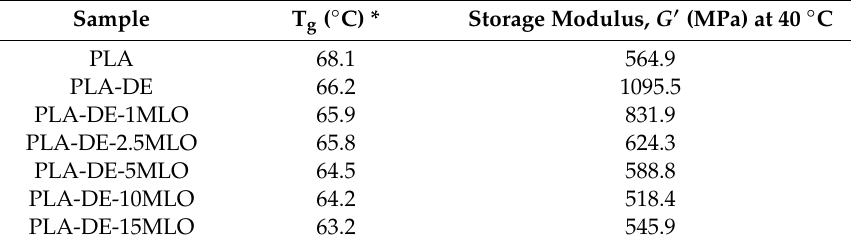
Table 5. Summary of some dynamic-mechanical thermal properties of PLA / DE with varying MLO loading.